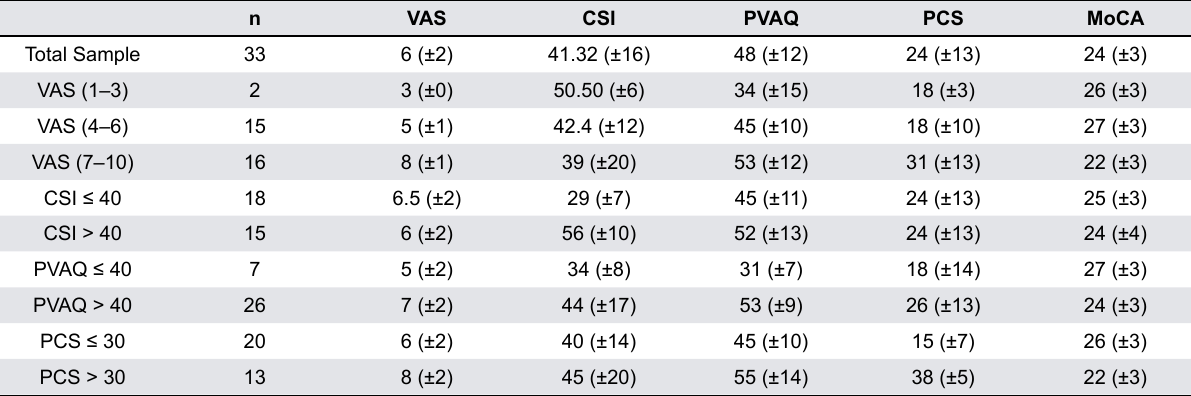
Table 3- Sample number (n), mean (standard deviation) of MoCA score (cognitive performance), VAS score (pain intensity), total CSI score (central sensitization), total PVAQ score (hypervigilance), and total PCS score (catastrophizing) by clusters of mild (VAS 1–3), moderate (VAS 4–6), or severe (VAS 7–10) pain intensity. Central sensitization indicated by CSI>40; hypervigilance indicated by PVAQ>40; pain catastrophizing indicated by